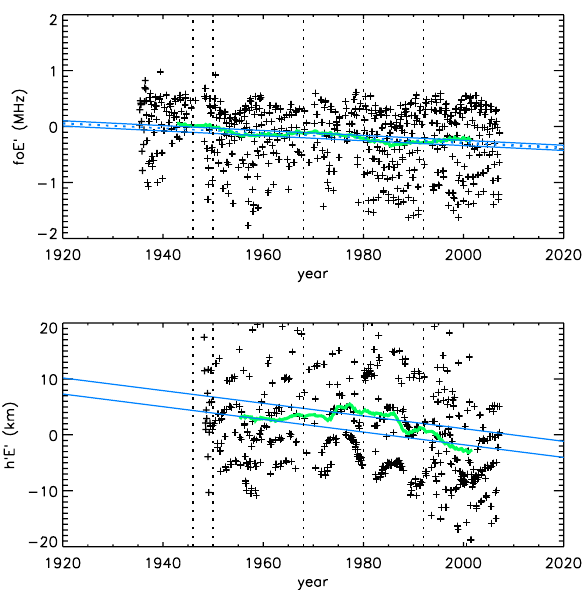
Fig. 3. Trends in f oE (upper panel) and h 0 E (lower panel). Indi- vidual symbols show the monthly mid-day medians (as in Fig. 1.); thick blue lines: smoothed time series; thin blue lines: linear fits to smoothed data; vertical dotted lines indicate dates when system changes were made. The trends are as follows: f oE , − 0.06MHz